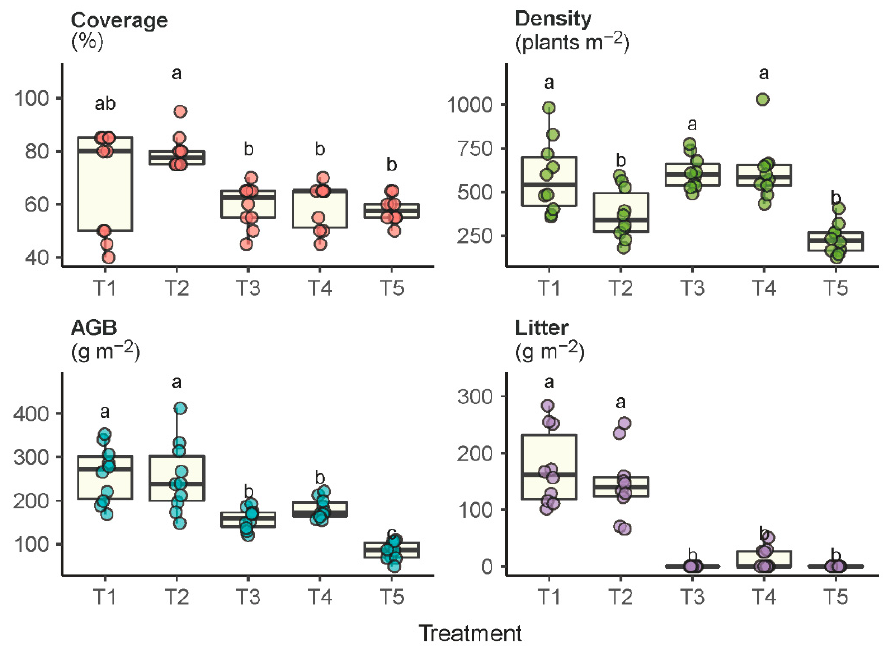
Figure 1. The importance values per plant species in each of the functional groups of Poaceae , forbs, sedges and legumes under the experimental treatments T1 through T5. Treatments with the same lowercase letter are not significantly different.